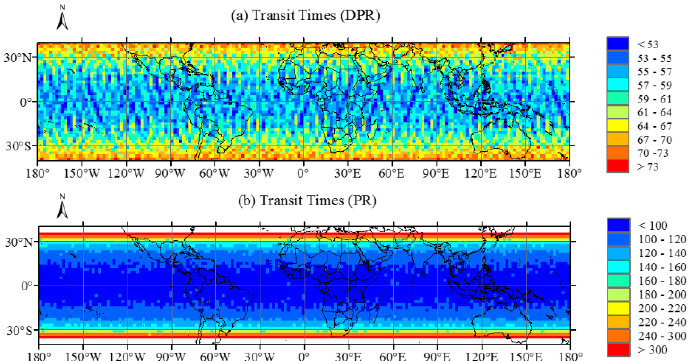
Figure 1. Numbers of transit times of: ( a ) the Global Precipitation Measurement mission dual frequency radar (GPM DPR); and ( b ) the Tropical Rainfall Measuring Mission Precipitation Radar (TRMM PR) within 2° × 2° pixels. DPR is represented by its normal scan swath (DPR_NS).